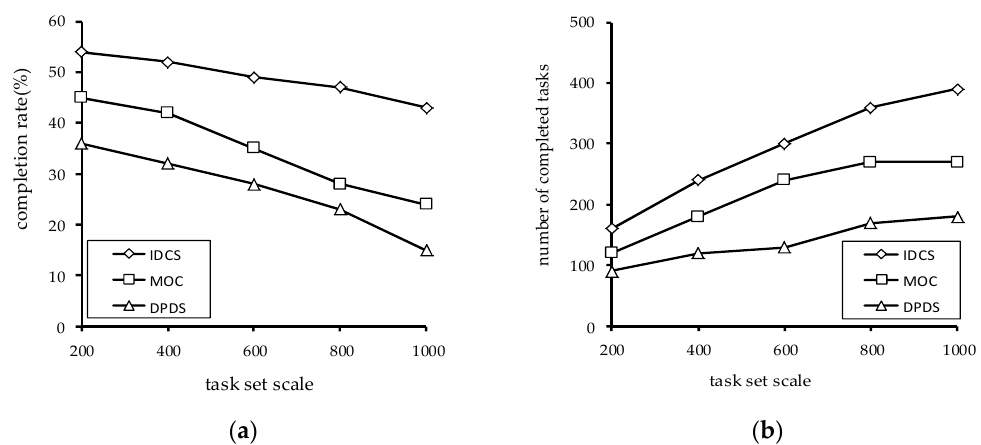
Figure 9. The impact of task set scale on the performance of the algorithms: ( a ) The impact of task set scale on task completion rate; ( b ) the impact of the task set scale on the number of tasks completed.